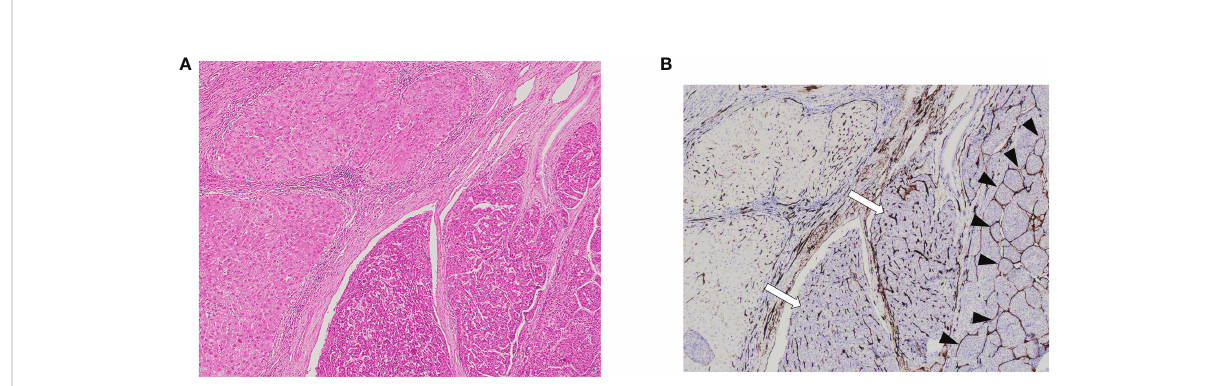
FIGURE 1 Vascular patterns in HCC and adjacent non-tumor liver parenchyma on hematoxylin stain section on low power fi eld of view [ (A) : 40X] and CD34 [ (B) : 40X]. Both VETC-positive (black arrowheads) and VETC-negative (white arrows) vascular patterns are seen in HCC tissue on the right side of the image, while the left side shows non-tumor liver parenchyma. HCC, hepatocellular carcinoma; VETC , vessels that encapsulate tumor